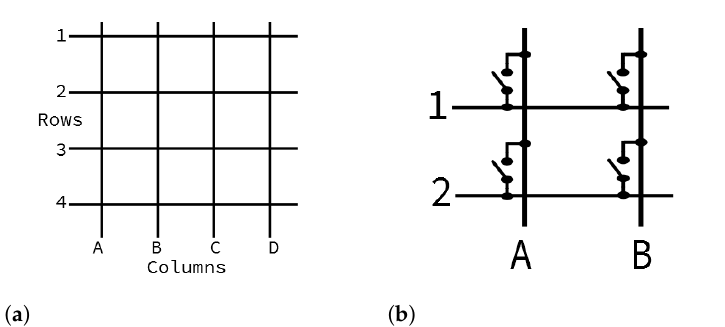
Figure 9. Matrix linked buttons. An array of rows and columns is depicted in ( a ). In ( b ), the switches are also represented to illustrate how all possible connections indicate a unique